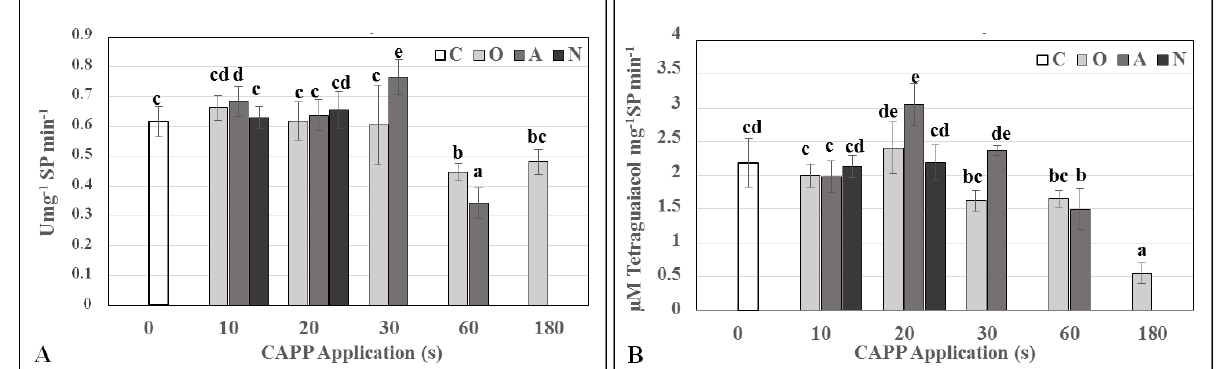
Figure 5. Activities of superoxide dismutase (SOD) ( A ) and guaiacol peroxidase (G-POX) ( B ) in 3-day-old barley seedlings after CAPP treatment. Variants: C—control/untreated barley grains; O10–O300: barley grains treated with plasma generated in oxygen atmosphere for 10, 20, 30, 60, 180 or 300 s; A10–A300: barley grains treated with plasma generated in ambient air for 10, 20, 30, 60, 180 or 300 s; N10–N300 barley grains treated with plasma generated in nitrogen atmosphere for 10, 20, 30, 60, 180 or 300 s. Different letters indicate significant difference at p -value < 0.05, bars are means of four experimental runs (one run represents 50 seeds per variant; three 1.5-g mixed samples were analyzed per experimental run and each variant) ± SD according to Tukey’s HSD test.